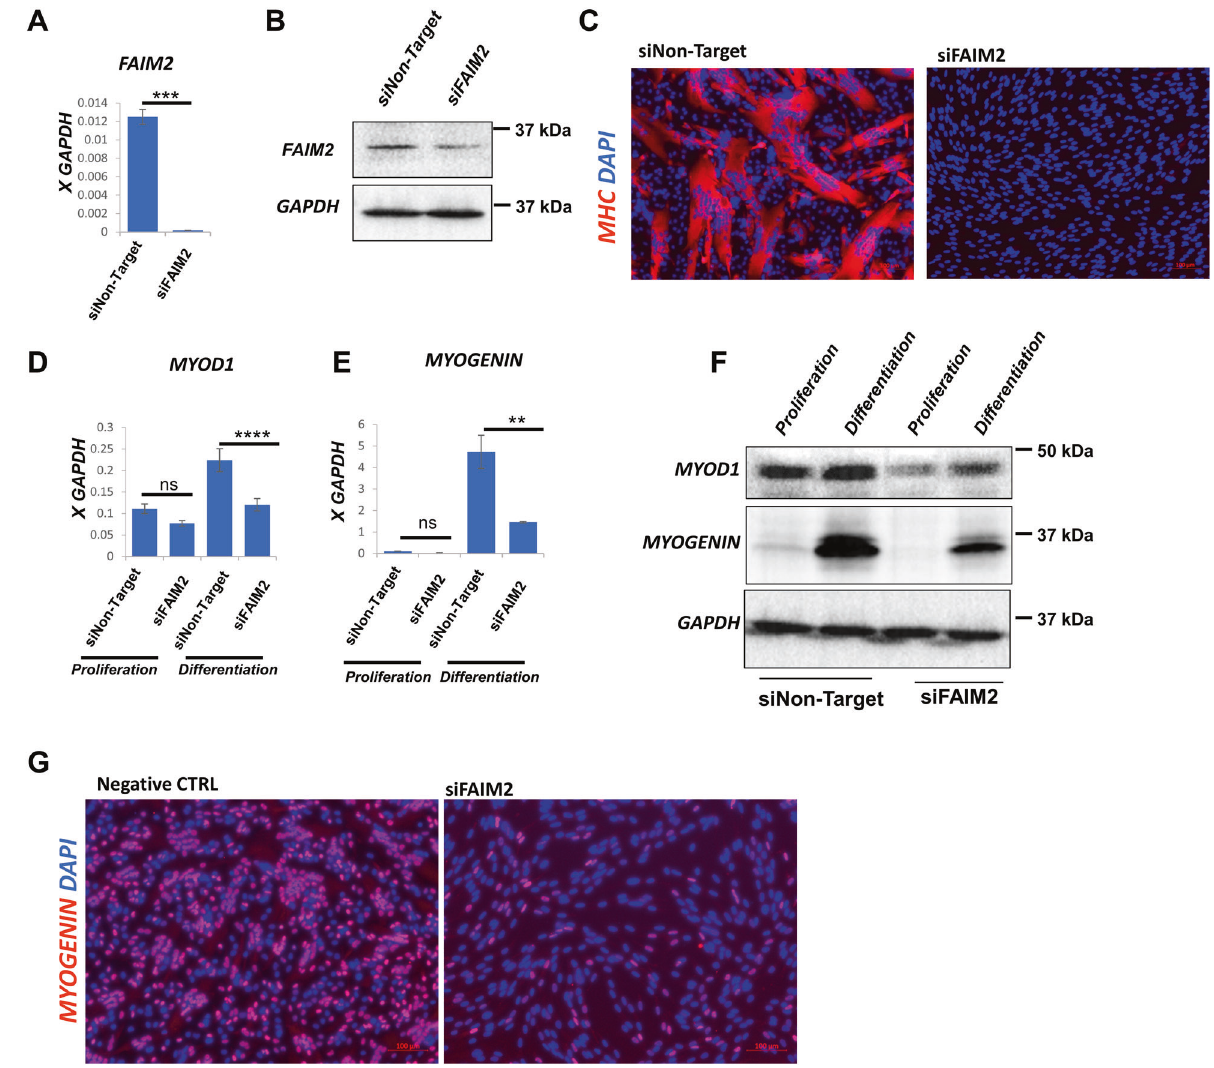
Fig. 4 siRNA knockdown of FAIM2 blocks myogenic differentiation. A RTqPCR for FAIM2 expression in LHCN-M2 myoblasts transfected with non-targeting siRNA (siNon-Target) or siRNA targeting FAIM2 (siFAIM2) for 72 h. Data are presented as mean ± SEM; *** P = 0.0001, by unpaired t -test ( n = 3). B Western blot for FAIM2 expression in LHCN-M2 myoblasts transfected with non-targeting siRNA (siNon-Target) or siRNA targeting FAIM2 (siFAIM2) for 72 h. C Immuno fl uorescent staining for MHC (red) and DAPI (blue) of LHCN-M2 myoblasts transfected with non- targeting siRNA (left) or siRNA targeting FAIM2 (right) for 72 h, then cultured for 24 h in differentiation medium. D RTqPCR for MYOD1 expression in LHCN-M2 myoblasts transfected with non-targeting siRNA or siRNA targeting FAIM2 mRNA for 72 h and then differentiated for 24 h. Data are presented as mean ± SEM; for ns P = 0.1463, **** P < 0.0001 by two-way ANOVA with Tukey ’ s post hoc test ( n = 3). E RTqPCR for MYOGENIN expression in the same cells shown in D . Data are presented as means ± SEM; for ns P = 0.9988, ** P = 0.0014 by two-way ANOVA with Tukey ’ s post hoc test ( n = 3). F Western blot for MYOD1 and MYOGENIN for the same cells shown in D . G Immuno fl uorescent staining of MYOGENIN (red) and DAPI (blue) of LHCN-M2iDUX4 myoblasts after transfection with 50 nM FAIM2 siRNA or Non-Target siRNA for 72 h followed by 24 h in differentiation